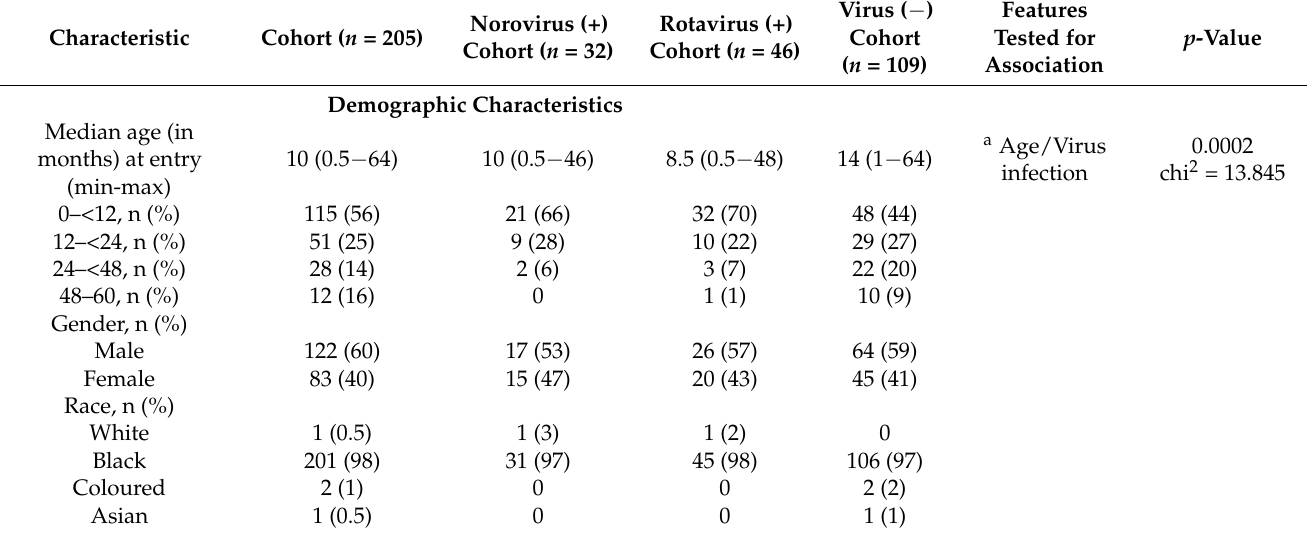
Table 1. Demographic and clinical characteristics of children with acute gastroenteritis ( n =